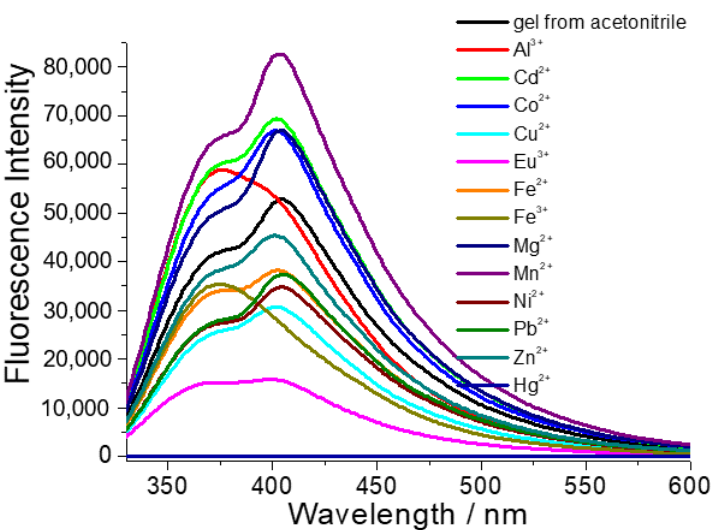
Figure 9. Fluorescence emission spectra of gels of 1 with different metal ions (1.0